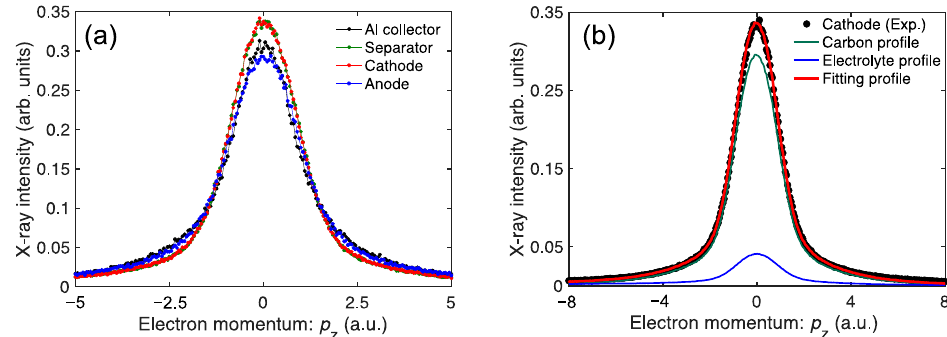
Figure 3. ( a ) Compton scattered X-ray energy spectrum obtained from Al collector, separator, activated carbon cathode and anode layer; ( b ) fitting analysis of the Compton scattered X-ray energy spectrum. Compton scattered X-ray energy spectrum of the cathode was then measured at charged and discharged states after 1, 2, 3, 4, 10, 15, 20, and 25 cycles. Figure 5 shows the modification of the S-parameter at the center and edge positions at each charged and discharged state. The S-parameters are normalized by the S-parameter value of the initial (discharged) state, after averaging in S-parameters obtained from the cathode region which are highlighted by the dark gray background color in Figure 4. Evidently, the S-parameter values decrease as the capacitor cell is charged, and then increase to the value of the initial state as the capacitor cell is discharged. The S-parameter changes by about 1% with each charge and discharge, indicating that lithium moves between the cathode and the anode during each cycle, as expected. To investigate the structural changes inside the capacitor cell resulting from the cycling, we plotted and analyzed the correlation between the rate of change in the X-ray intensity and the rate of change in the S-parameter at